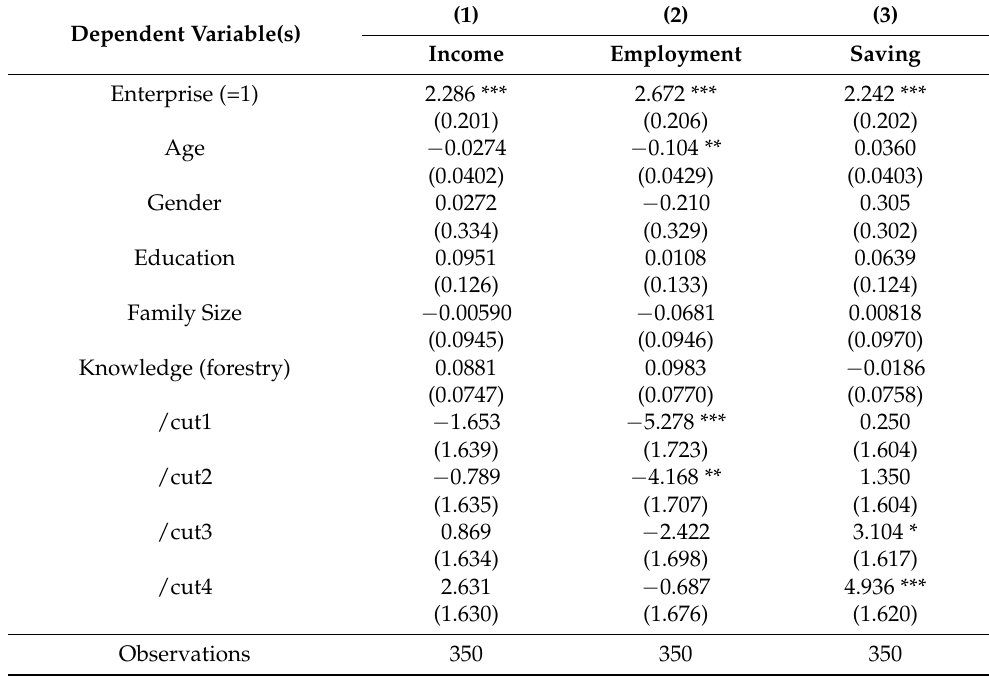
Table 4. SSAF and